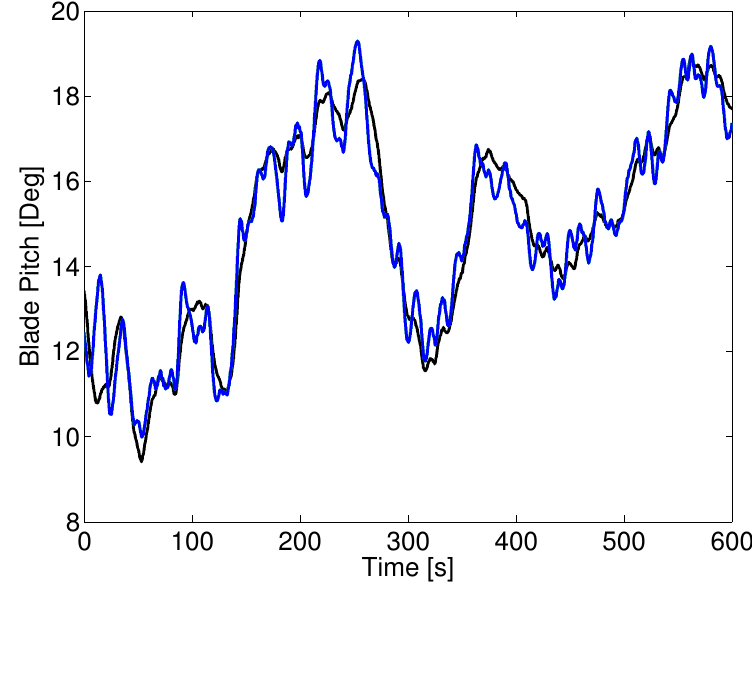
Figure 13. Perpendicular wind-wave forces with a peak wave period of 10 s: blade pitch angle. The blue is the LQR2 controller, while the black is the